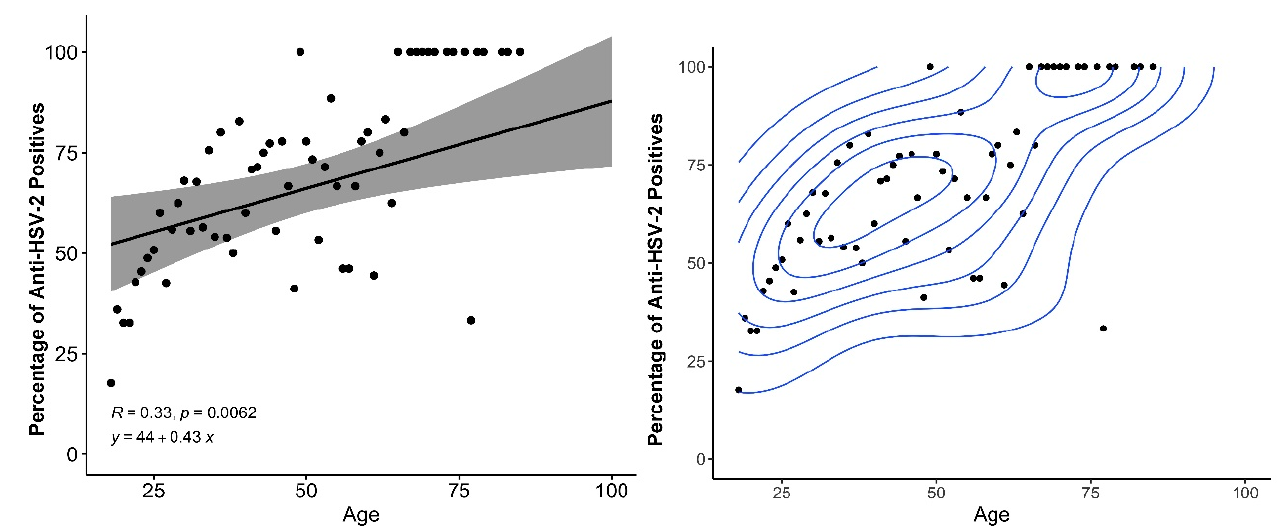
Figure 1. Relationship between age of participants and percentage of HSV-2 positive individuals, with linear increase ( left ) and density estimation with two separated age groups ( right ).